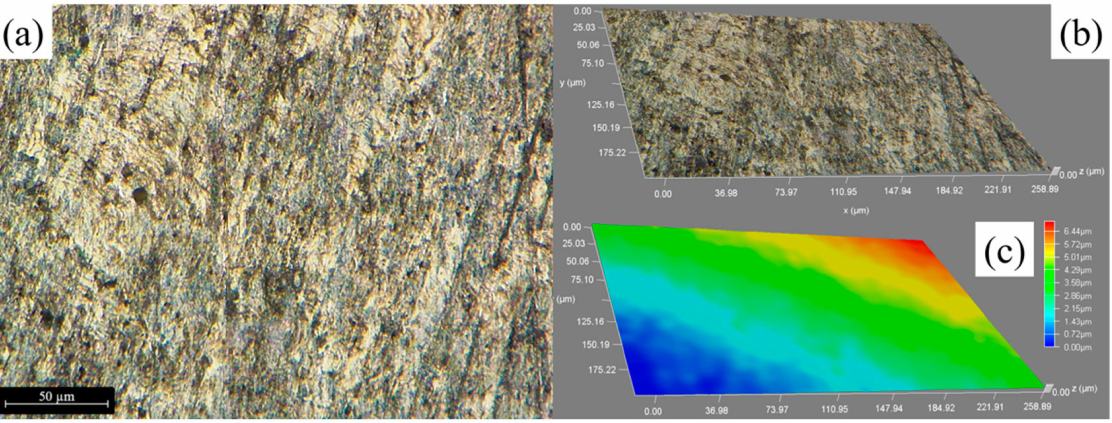
Figure 5. The 2D ( a ) and 3D ( b , c ) surface morphologies of 7075 aluminum alloy after corrosion in real